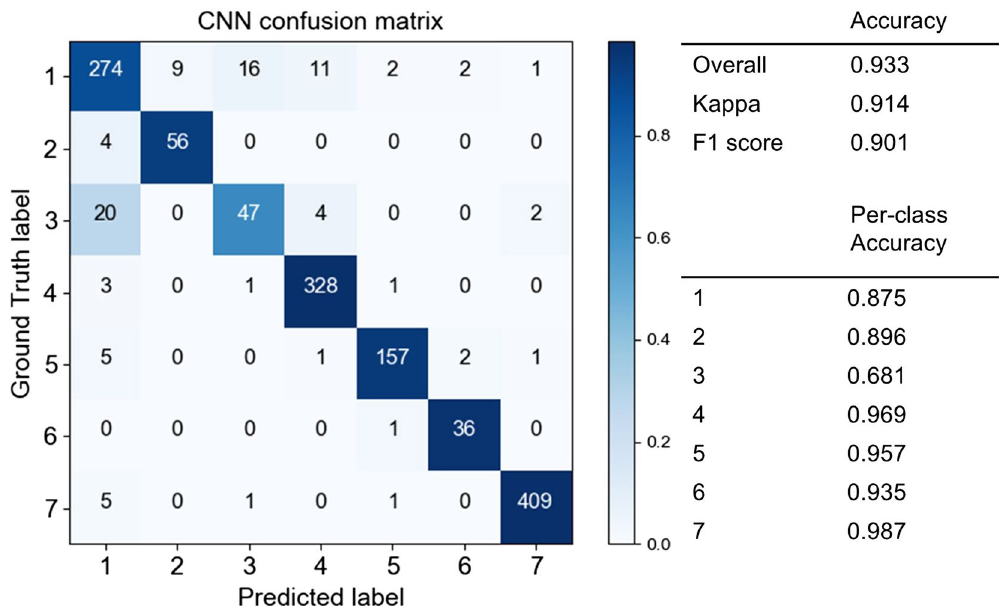
Figure 8. Confusion matrix of the CNN in the leaf season (Model 2). (Class 1: deciduous broad-leaved tree; 2: deciduous coniferous tree; 3: evergreen broad-leaved tree; 4: Chamaecyparis obtuse ; 5: Pinus elliottii or Pinus taeda ; 6: Pinus strobus ; 7: